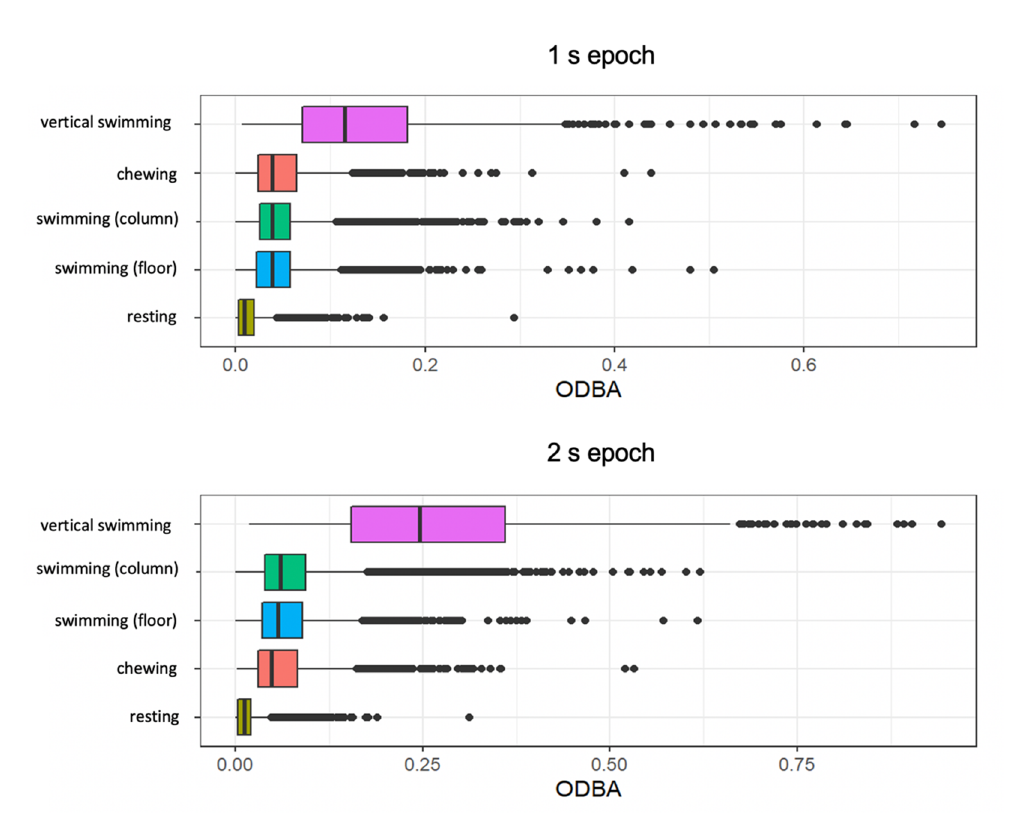
Figure 2. Boxplots of overall dynamic body acceleration (ODBA) for initial ethogram of behaviours. Note, swimming in the water column and swimming on the floor were combined for subsequent modelling analysis.